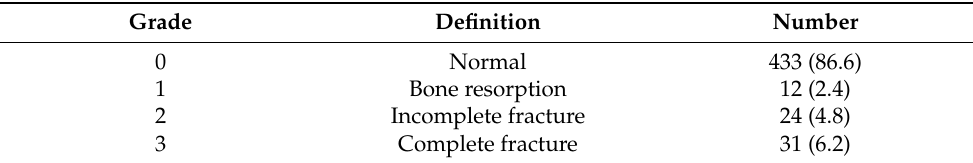
Figure 4. Breakdown of sports activities. The number indicates number of patients. The mean interval between MRI and CT was 3 ± 1.78 days. Out of 500 pars interartic- ularis, 67 fractured and 433 normal pars interarticularis were detected (Table 1). Fractures were detected from L3 to L5 level, and there were no patients who had the lesion at L1 or L2. Table 1. Number of pars interarticularis for each fracture